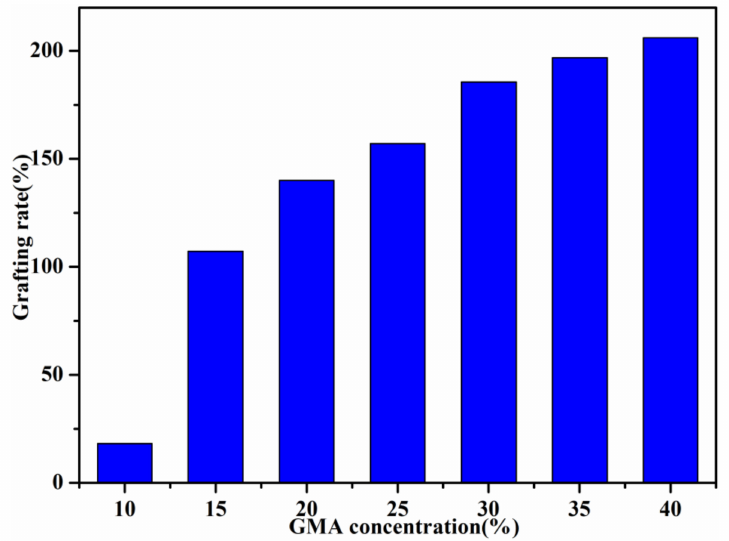
Figure 5. The effect of GMA concentration on the GY (Absorbed dose = 200 kGy, dose rate = 20 kGy/pass).